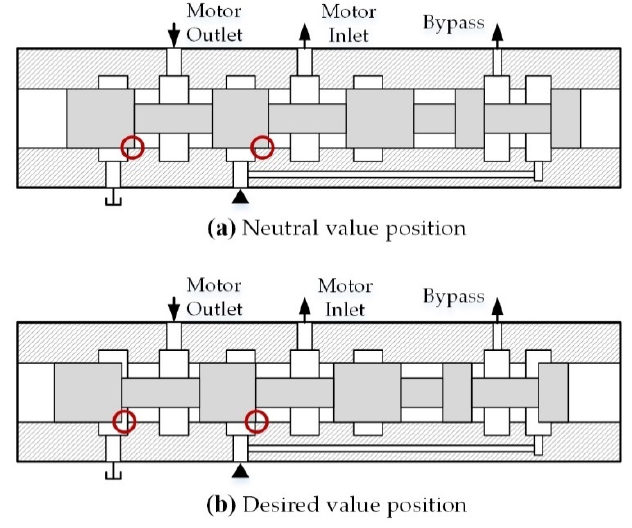
Figure 5. Schematic diagram of main valve overlap.